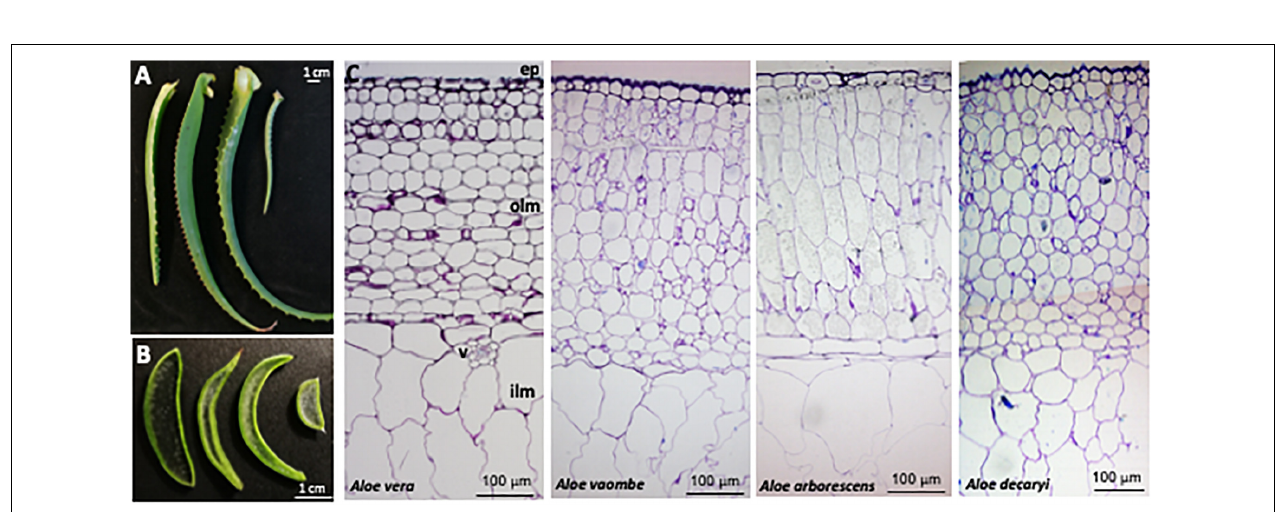
FIGURE 3 | Anatomy of four Aloe species, (A) Leaves and (B) cross-sections from left to right of Aloe vera , A. vaombe , A. arborescens and A. decaryi . (C) Cross-sections from left to right of Aloe vera , A. voombe , A. arborescens and A. decaryi stained with Toluidine blue. Marked are ep, epidermis; olm, outer leaf mesophyll; v, vasculature; ilm, inner leaf